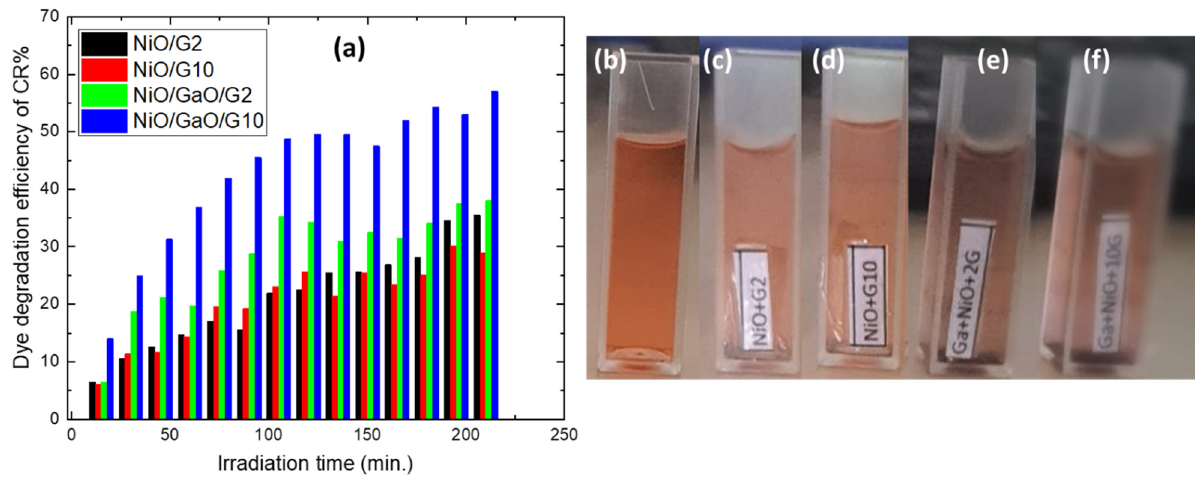
Figure 7. Photocatalytic degradation of Congo Red (CR) on the nanocomposites: ( b – f ) change in watercolor including CR dye for ( a ) only CR; ( b ) NiO/G2; ( c ) NiO/G10; ( d ) NiO/Ga 2 O 2 /G2; and ( e ) NiO/Ga 2 O 2 /G10 after UV illumination for 210 min.